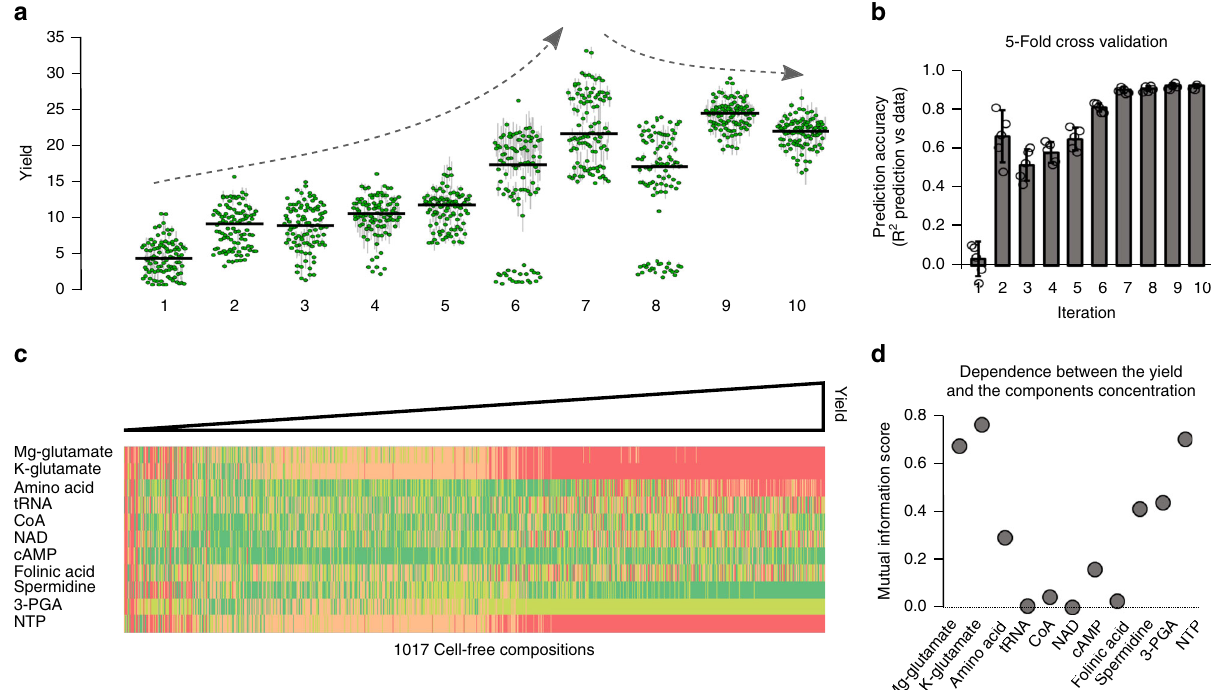
Fig. 3 Impact of compounds concentration on protein production. a Yield evolution amongst ten iterations. The green dots are the mean yields of three replicates obtained in the same plate with the same buffer composition ( n = 3 independent samples). The vertical gray lines stand for the standard deviation of the three replicates. The horizontal black line is the median value of all the yields obtained during an iteration. The Arrows represent the evolution of the maximal yields value. b Quanti fi cation of the predictive accuracy of the model using a 5-fold cross validation. Data are mean values and the vertical black lines stand for the standard deviation of the fi ve values ( n = 5 scores). c Cell-free compositions tested in the study sorted by yield level. A row stands for one mix composition, the color code is the same as used in Fig. 1a. d Results of a mutual information analysis, using the 1017 compositions, of the relationship between the yield and each chemical compound. Source data are provided in the Source Data fi